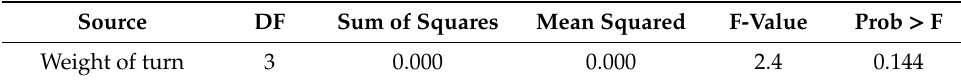
Table 6. One-way ANOVA for the weight of turn on screen size. n = 12. Source DF Sum of